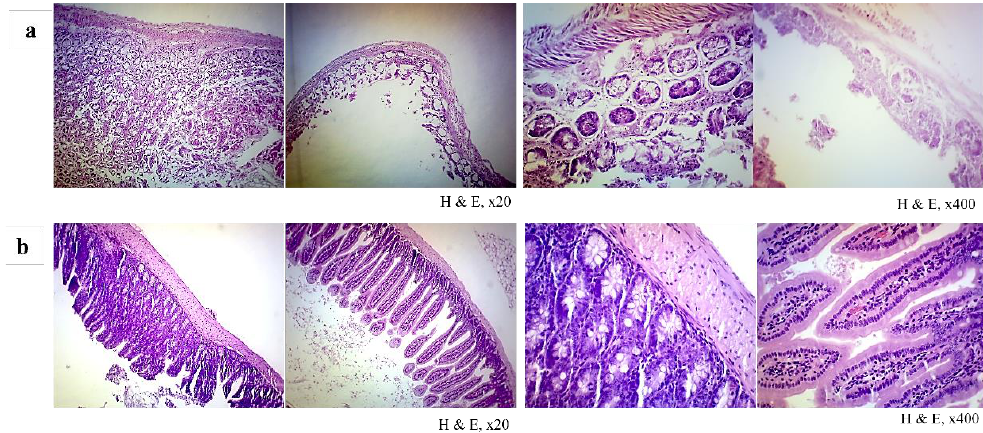
Figure 9. Histopathology of the intestines of unimmunised mice in Group B ( a ) and immunised mice in Group C ( b ) after ETEC challenge (H and E, ×20 and ×400). ( a ) Section from the intestines of unimmunised mice in Group B shows severe pathological alterations in the intestine, including necrosis, congestion and haemorrhage, and neutrophil infiltration. Whereas ( b ) section from the intestines of immunised mice in Group C can be seen within normal limits.